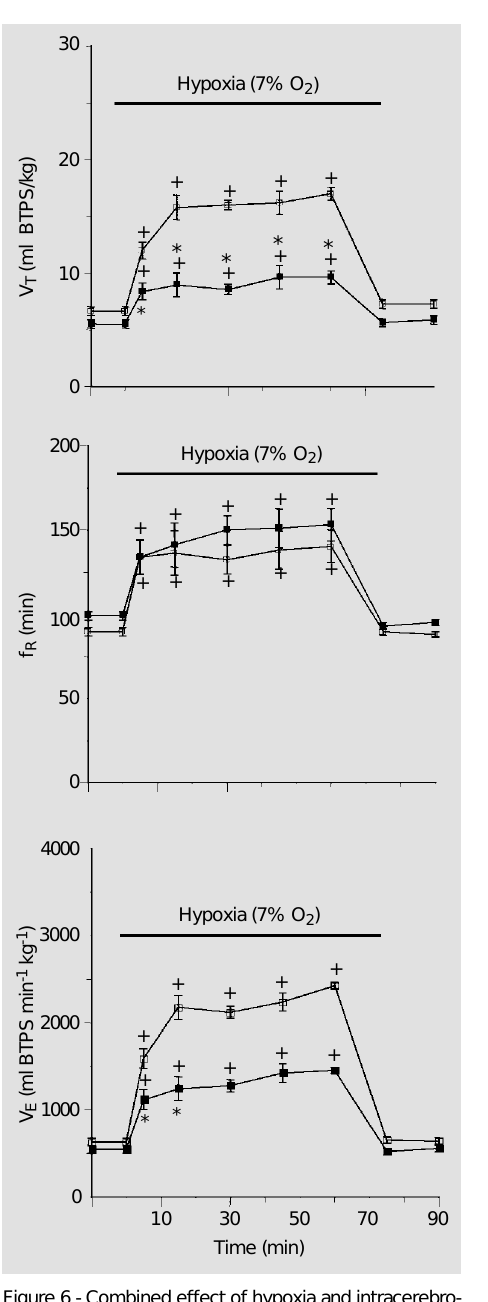
Figure 6 - Combined effect of hypoxia and intracerebro- ventricular ( icv ) injection of N G -nitro-L-arginine methyl ester (L-NAME; 250 µg/µl) on tidal volume (V T ), respira- tory frequency (f R ) and pulmonary ventilation (V E ) of LC- lesioned rats that received an icv injection of saline (open squares) (N = 5) or L-NAME (filled squares) (N = 7). Values are reported as means ± SEM. + Significant in- crease (P<0.05) in V T , f R and V E after hypoxia compared to normoxia. *Significant difference (P<0.05) in V T and V E of L-NAME-treated rats compared to saline. BTPS, Body temperature, pressure, saturated with water vapor.